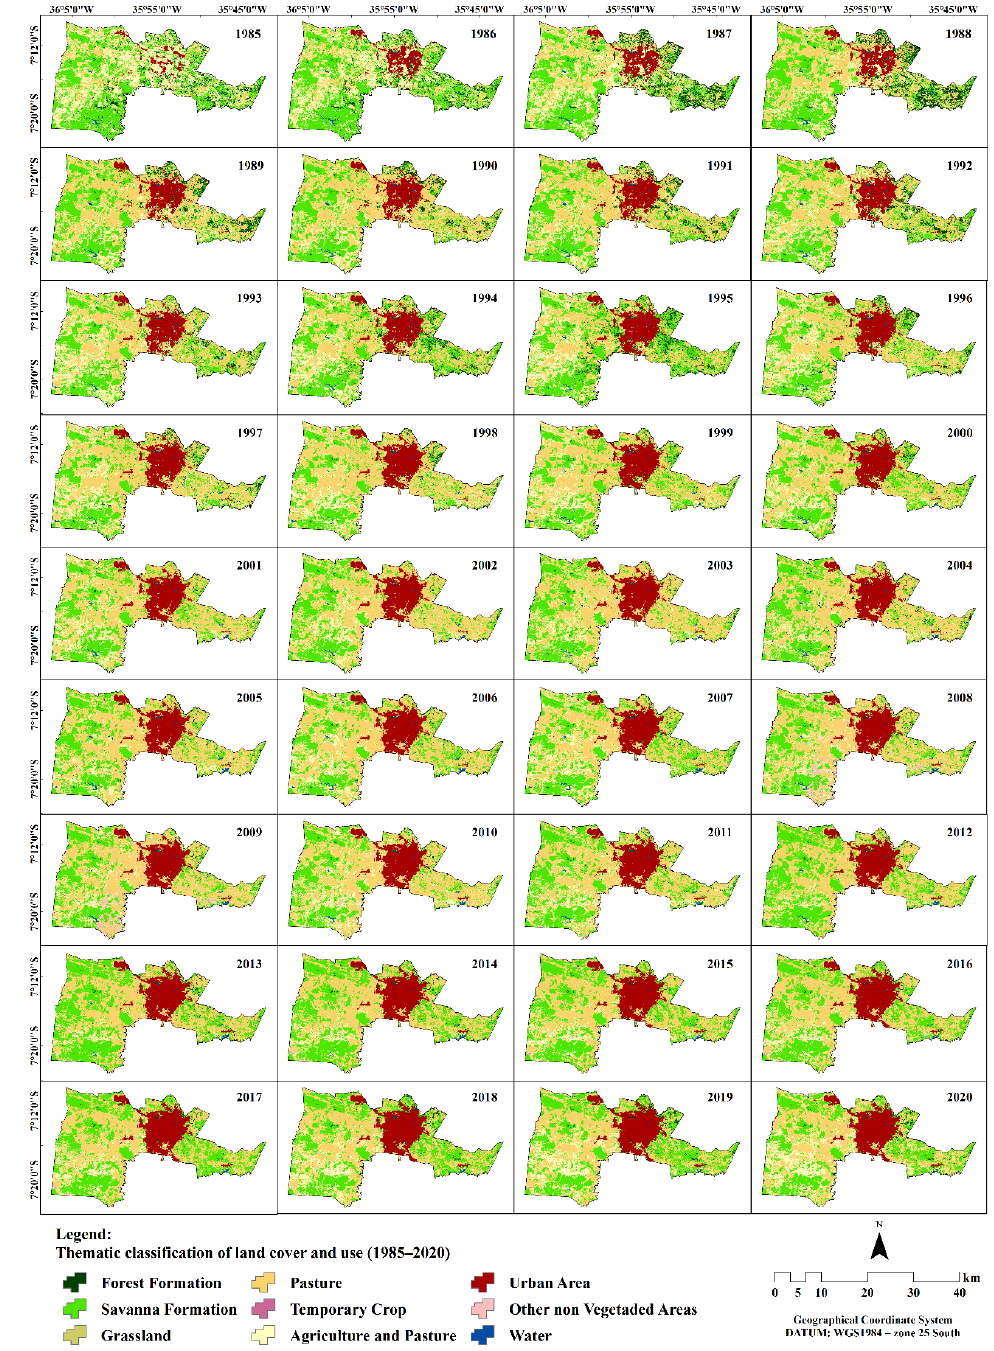
Figure 2. Annual spatiotemporal monitoring of land cover and use in the semiarid region of Cam- pina Grande − PB, between 1985 and 2020. Data source: MapBiomas Brazil—Collection 6.0. Grande − PB, between 1985 and 2020. Data source: MapBiomas Brazil—Collection